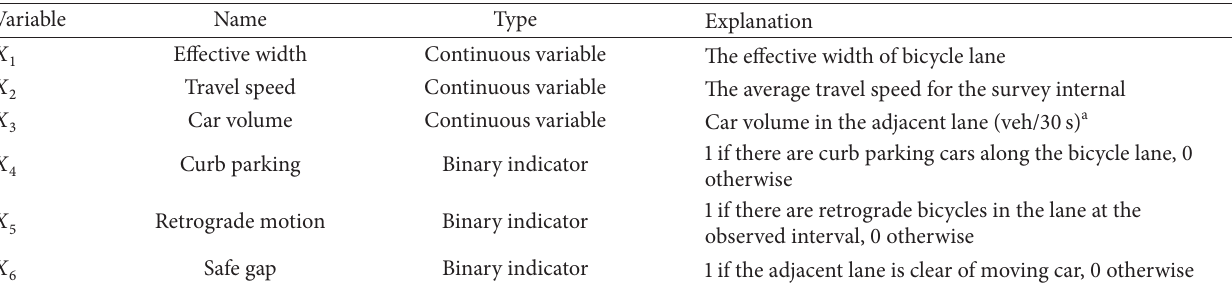
Table 2: External factors and